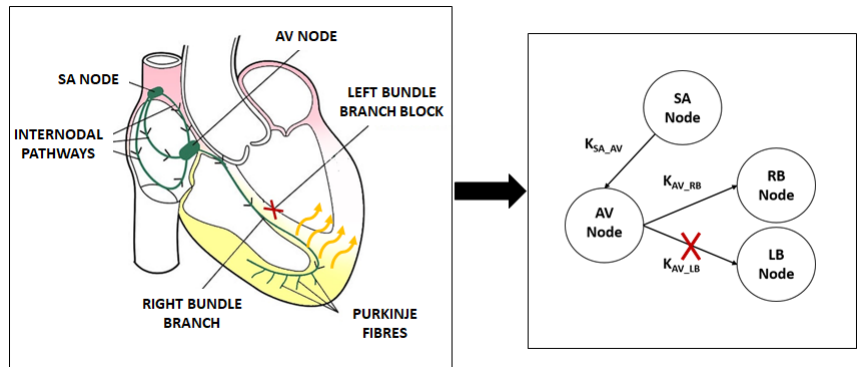
Figure 5. Left Bundle Branch Block (LBBB) and the four coupled oscillators model.